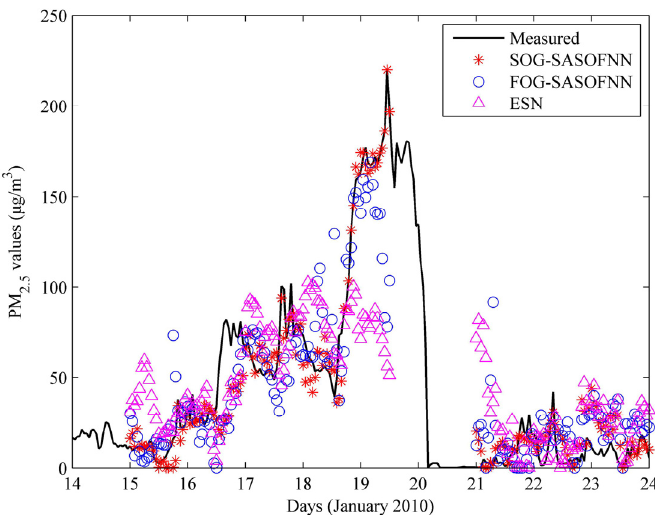
Figure 3. Time series variation of measured PM 2.5 concentrations and the modeled results of SOG-SASOFNN, SASOFNN with first order gradient algorithm (FOG-SASOFNN) and echo state network (ESN) at SDZ from 14 to 23 January 2010.